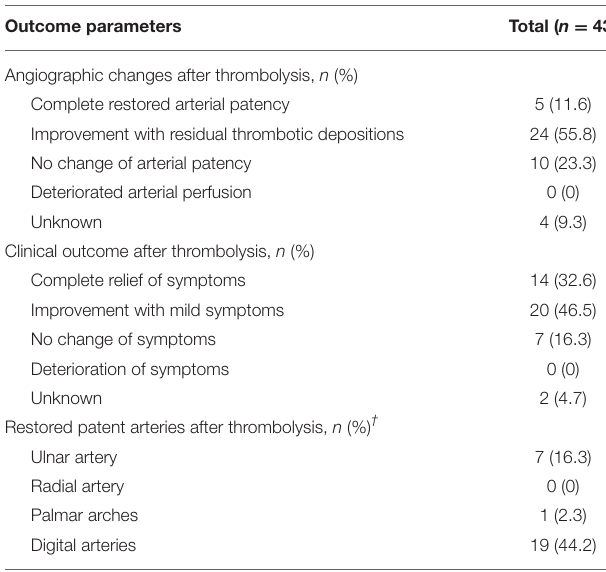
TABLE 4 | Patients’ angiographicand clinical outcome after intra-arterial thrombolysis. Outcome